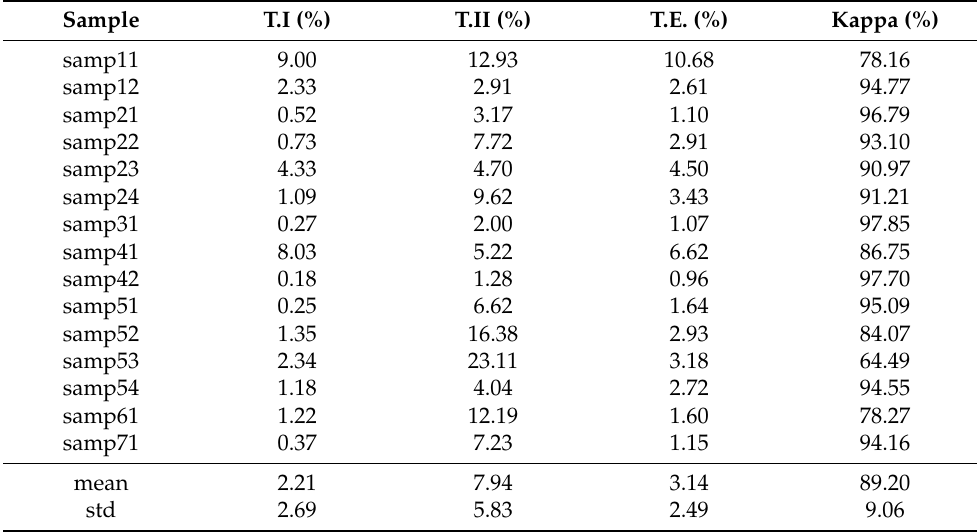
Table 4. Errors and kappa coefficients of the ASI filtering results for all